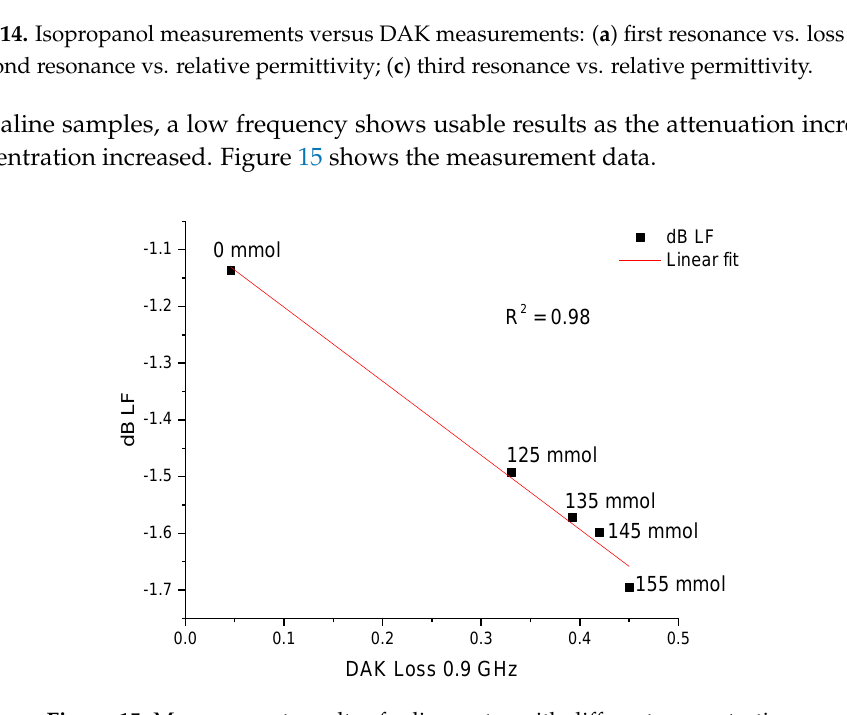
Figure 15. Measurement results of saline water with different concentrations.